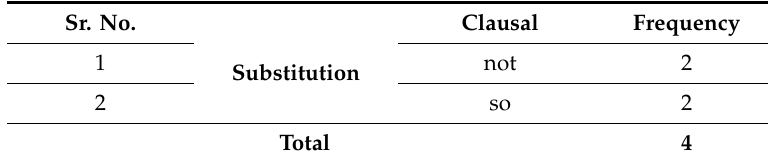
Table 25. Clausal substitutions.